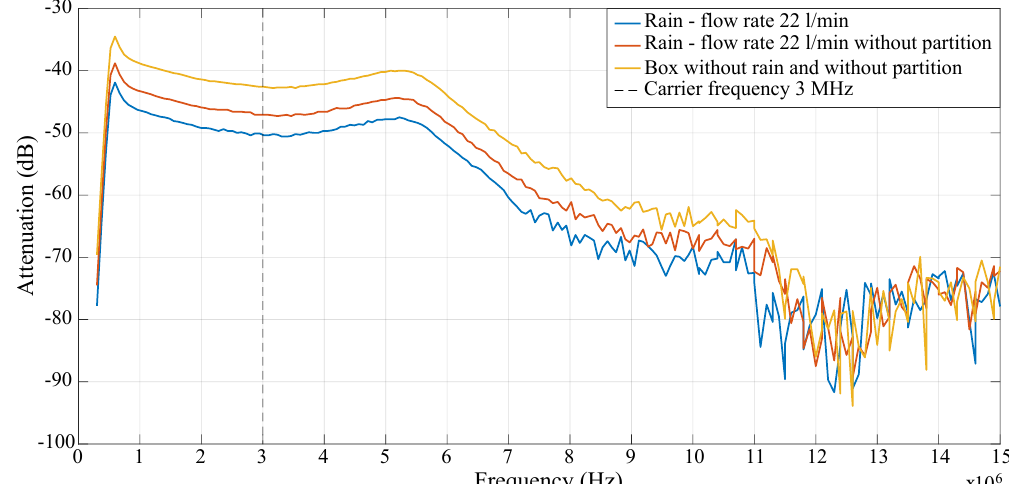
Figure 32. Attenuation characteristics of Octavia tail-light for scenario 4-Rain 22 L/min—comparison of intended setup and adjusted setup without partition.